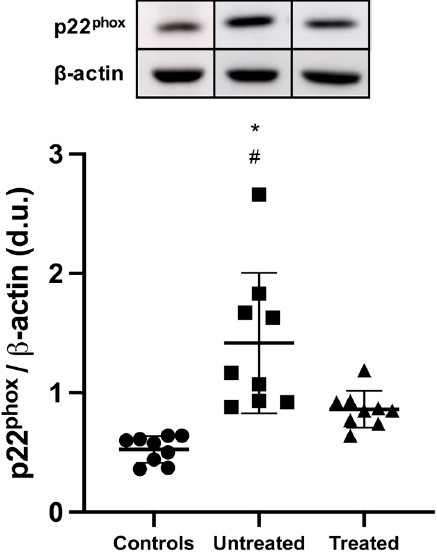
Figure 1. p22 phox protein expression. A representative Western blot of protein lysates harvested from controls, untreated ADPKD patients, and tolvaptan-treated ADPKD patients. Compared to controls, p22 phox expression was significantly increased in untreated ADPKD (*: p < 0.001) and in treated ADPKD patients (#: p = 0.015).